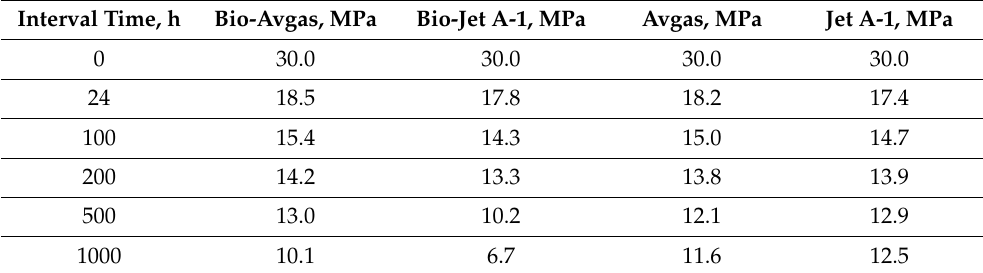
Table 1. Experimental contact pressure values of the AFO gasket for different fuels. Interval Time, h